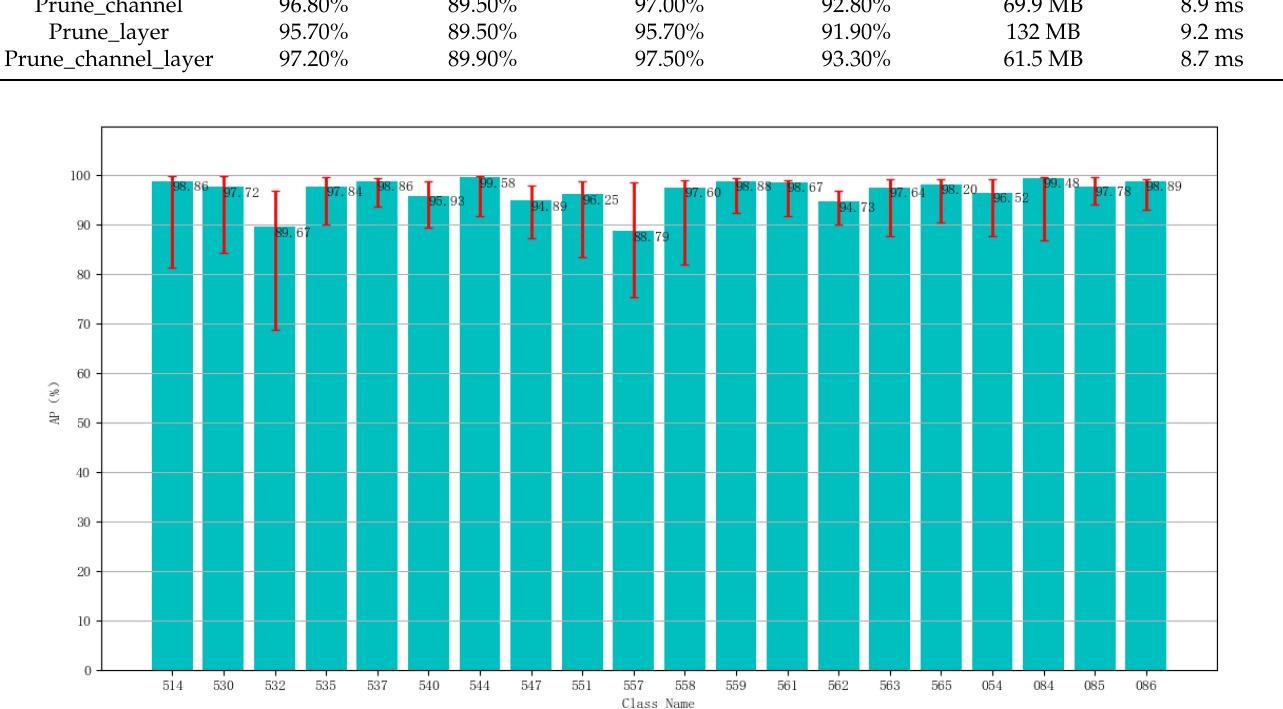
Figure 11. 10-Fold cross-validation results of our